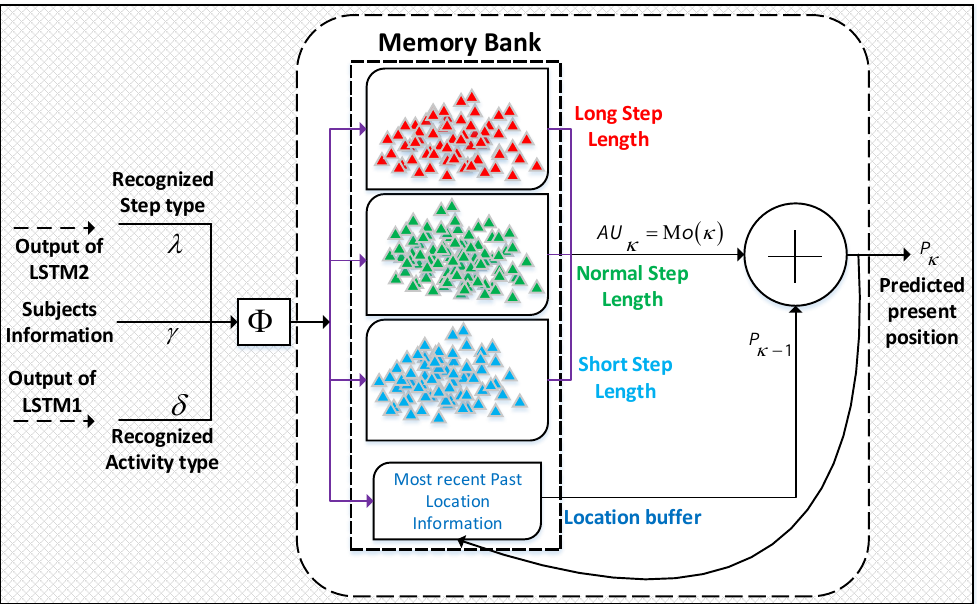
Figure 7. Operation of moving distance